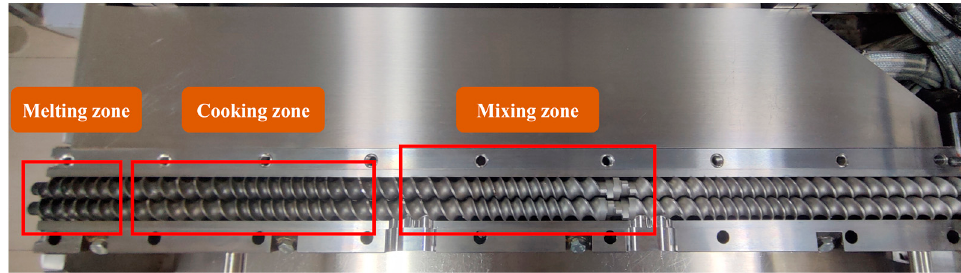
Figure 1. Position of mixing zone, cooking zone, and melting zone in barrel of extruder.